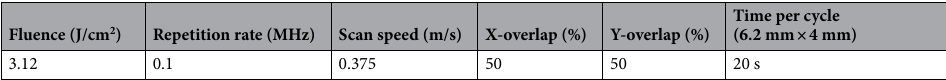
Table 3. The selected lasering parameters and the processing time per lasering cycle for a 6.4 mm × 4 mm region of interest (ROI).